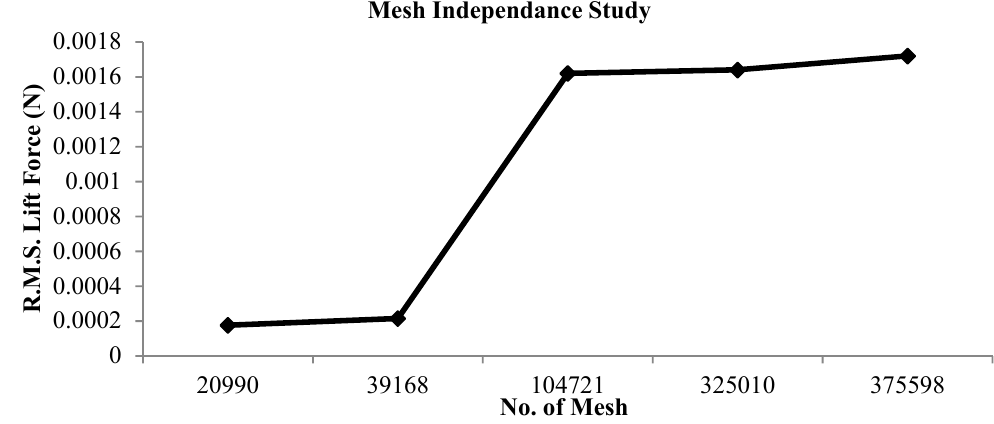
No. of Figure 12. Graph of the mesh independence study. Figure 12. Graph of the mesh independence study. Figure 12. Graph of the mesh independence study.